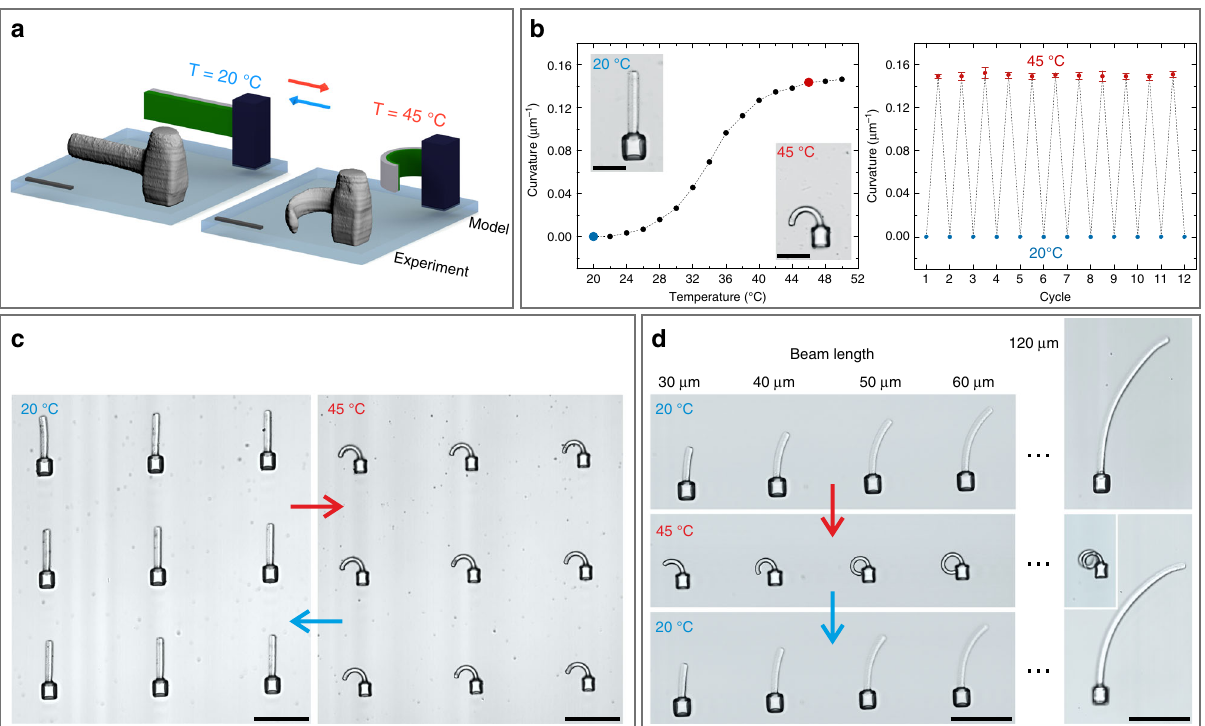
Fig. 3 Temperature-induced actuation using pNIPAM-based hetero-microstructures. a Scheme of bi-material hetero-structures with the two materials highlighted in green and gray, lower and higher dose exposure, respectively. These can be compared with the 3D reconstructions of measured fl uorescence image stacks. The two temperatures T = 20 °C and T = 45 °C are highlighted in blue and red, respectively. The beams start straight at T = 20 °C and are curved at T = 45 °C. b Curvature, i.e., inverse radius obtained by fi tting a circle to the experimental data, versus temperature. The right-hand side panel shows the result of twelve temperature cycles without deterioration (error bars are s.d.). c Bright- fi eld optical micrographs of a 3 × 3 array of nominally identical structures to demonstrate the reproducibility. d Temperature dependence of fi ve structures with different beam lengths prepared under identical fabrication conditions. Scale bars are 20 µ m in a and b and 50 µ m in c and